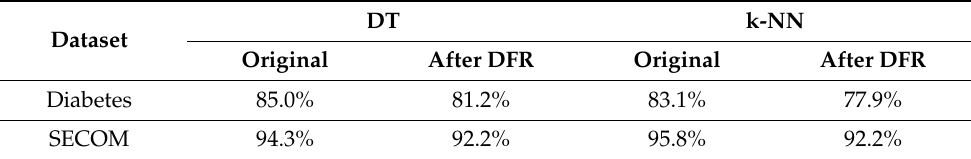
Table 1. Classifiers’ performance (accuracy) before and after